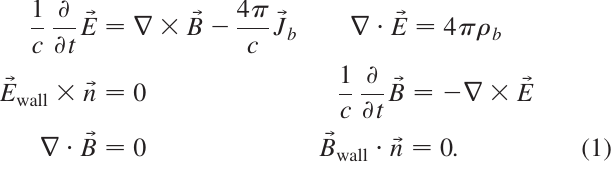
FIG. 1. Measured and simulated loss factor of the transport line (LTU) and undulator vacuum chamber of LCLS. Symbols correspond to the results of different measurements. The con- tinuous dark yellow line shows the numerical